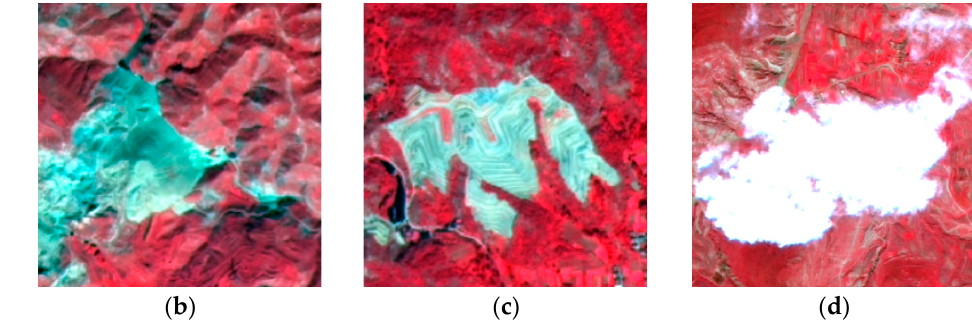
Figure 3. The proposed improved YOLOv5 tailings ponds detection framework.